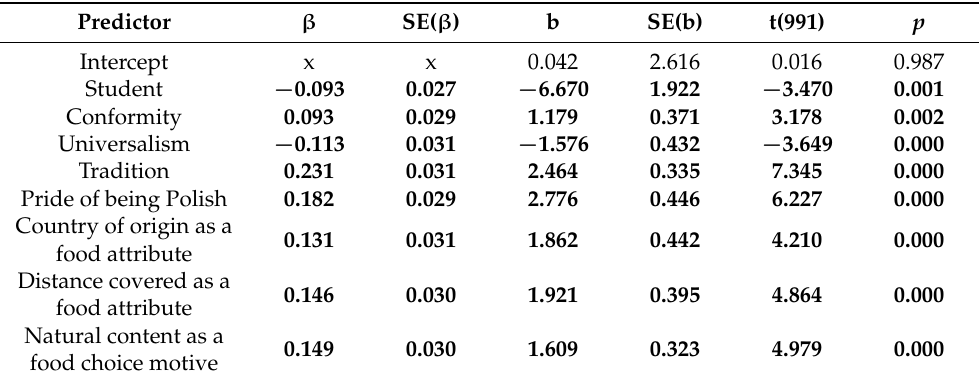
Table 4. Selected predictors of consumer ethnocentrism in the food market (a retrograde stepwise regression model).